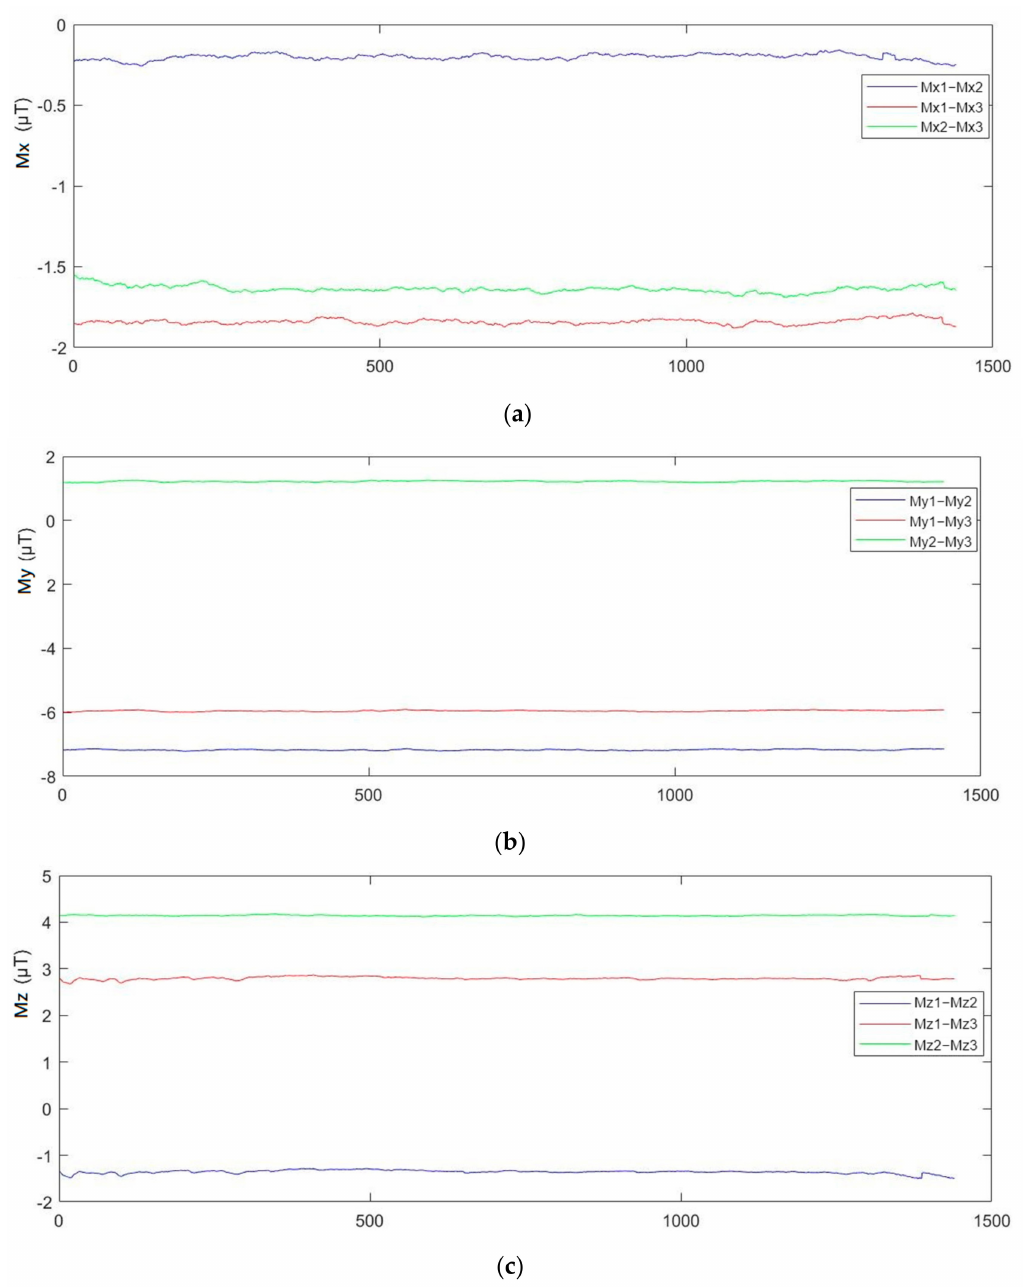
Figure 10. Differentiation of each magnetic signal component pair collected by: ( a ) sensor X; ( b ) sensor Y; ( c ) sensor